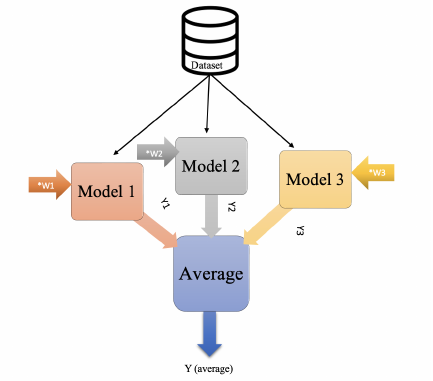
Figure 10. Weighted average